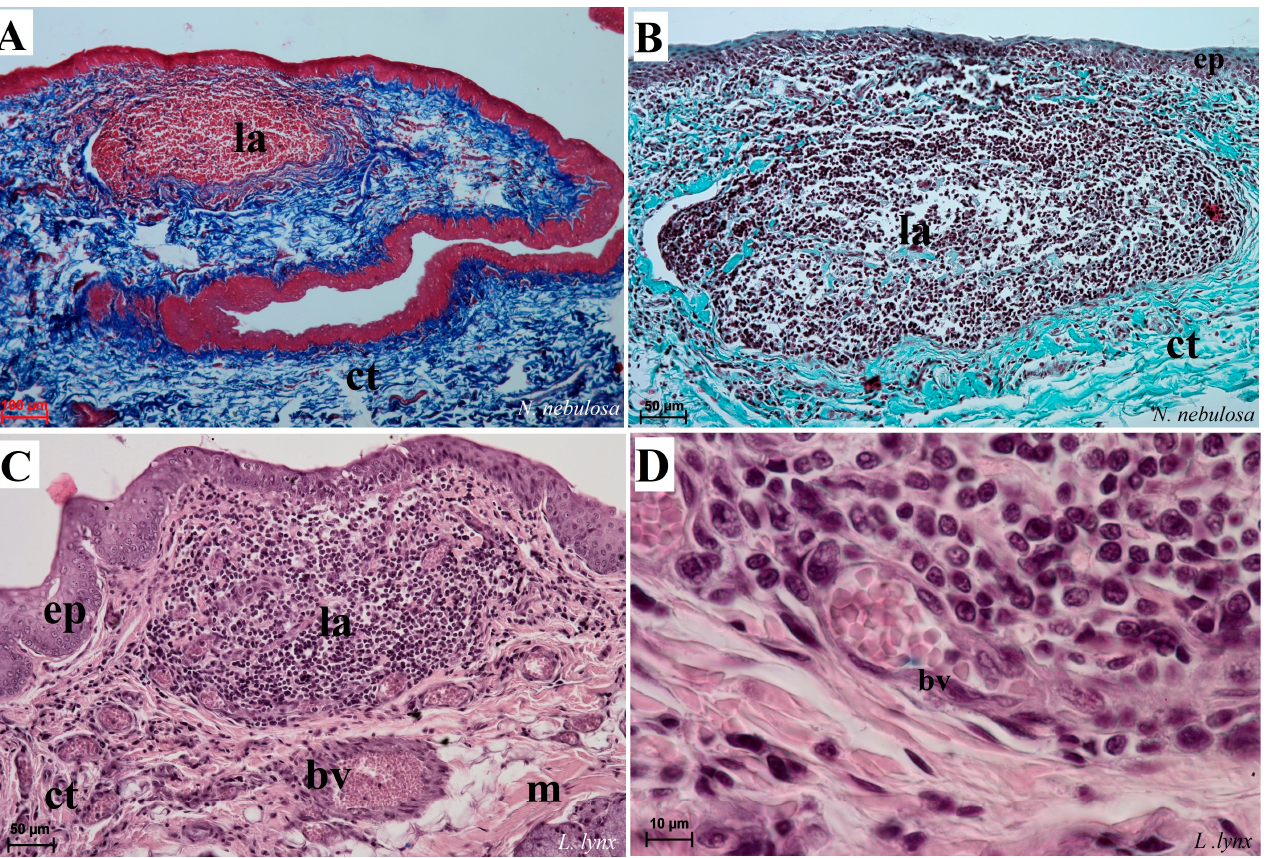
Figure 15. Histological analysis of the dorsal surface of root of the tongue with the aggregation of the lymphocytes and macrophages of N. nebulosa ( A , B ) and L. lynx ( C , D ). ( A – C ) Aggregation of lymphocytes within the root of the tongue. ( D ) Magnification of the venule containing numerous erythrocytes surrounded by aggregates of the leukocytes (mainly macrophages and lymphocytes). Azan trichrome staining ( A ); Masson–Goldner trichrome staining ( B ); H&E staining ( C , D ). Bar = 100